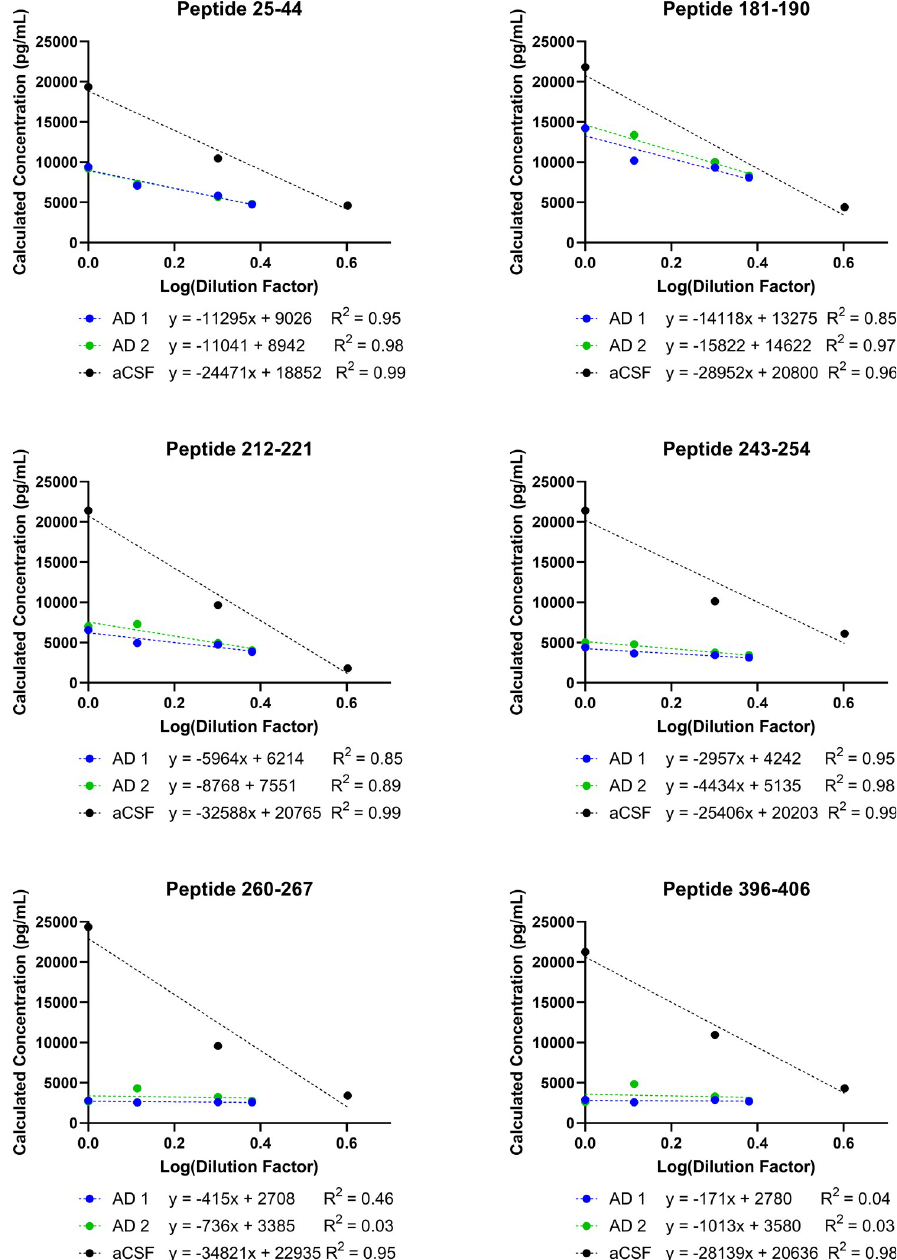
Fig 2. Test of dilutional linearity and parallelism between endogenous tau protein in Alzheimer’s Disease CSF and recombinant tau 441 in artificial CSF. A linear regression analysis of calculated tau concentration versus dilution factor was performed on AD CSF and artificial CSF matrices and compared for six tau surrogate peptides. Peptide 354–369 was not identified in either undiluted AD CSF sample, so it was excluded from analysis. A. Surrogate peptide 25–44 demonstrates dilutional linearity in all matrices, but AD CSF and reference standard curve are not parallel. B. Surrogate peptide 181–190 demonstrates dilutional linearity in all matrices, but AD CSF and reference standard curve are not parallel. C. Surrogate peptide 212–221 demonstrates dilutional linearity in all matrices, but AD CSF and reference standard curve are not parallel. D. Surrogate peptide 243–254 demonstrates dilutional linearity in all matrices, but AD CSF and reference standard curve are not parallel. E. Surrogate peptide 260–267 does not show dilutional linearity in AD CSF samples. F. Surrogate peptide 396–406 does not show dilutional linearity in AD CSF